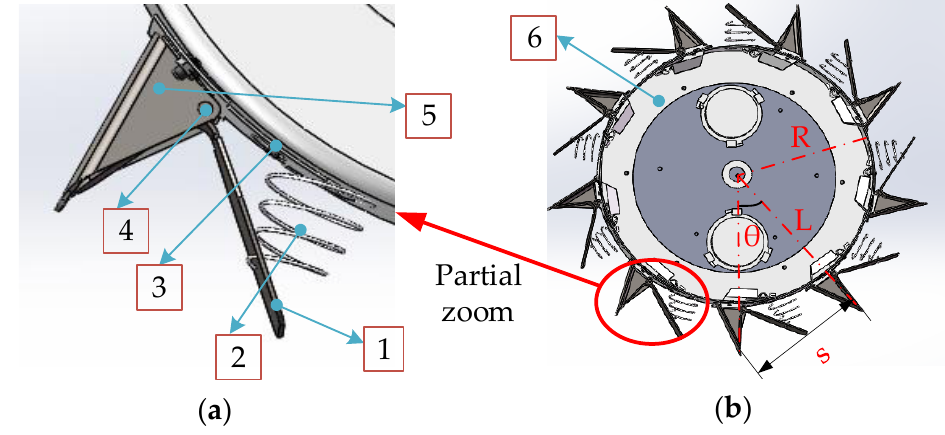
Figure 1. Structure schematic diagram of dibber wheel and duckbill. ( a ) Duckbill; ( b ) dibber